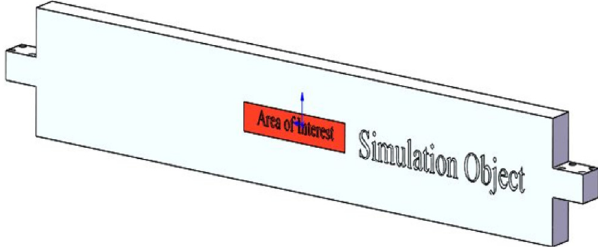
Fig. 4. Analyzed object with the area of interest.